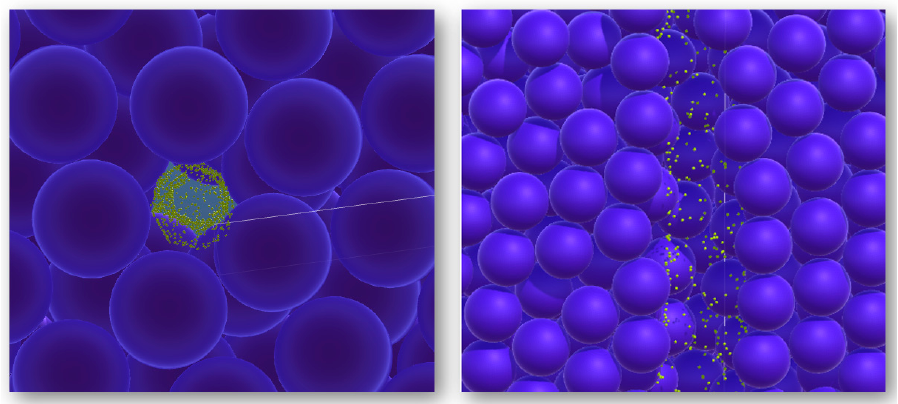
Figure 15. Scale effect of VWMs. ( Left ): VWMs (diameter = 29.136 cm) collide with the artificial point cloud (bottom view); ( Right ): VWMs (diameter = 10 cm) collide with the same point cloud (front view).